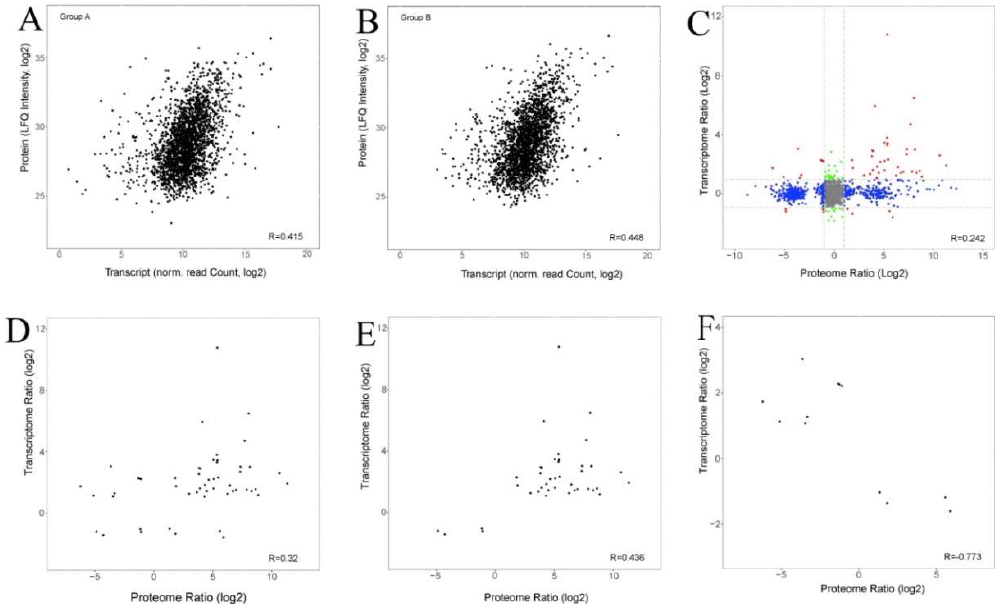
Figure 3. Comparison of expression ratios from transcriptome (y-axis) and proteome (x-axis) profiling. ( A ) Scatterplots of the relationship between genes quantified in both transcriptomic and proteomic analysis in 16C1369A; ( B ) Scatterplots of the relationship between genes quantified in both transcriptome and proteomic analysis in 16C1369B; ( C ) Scatterplots of the relationship between genes quantified in both transcriptomic and proteomic analysis; ( D ) Scatterplots and correlation coefficients between DEPs and DEGs in both transcriptomic and proteomic analysis; ( E ) Scatterplots and correlation coefficients between proteins and genes which showed the same types of changes in expression; ( F ) Scatterplots and correlation coefficients between proteins and genes which showed opposing changes in expression. Gray dots: absence of DEPs and DEGs; red dots: DEPs and DEGs; green dots: DEGs present and DEPs absent; blue dots: DEPs present and DEGs absent. The data were